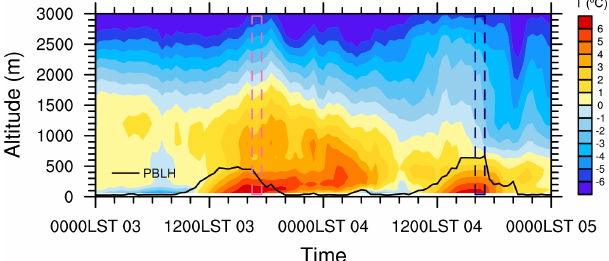
Figure 4. Temporal evolution of the EXP_Ctrl simulated temper- ature profile over Baoding. The pink and blue dashed boxes corre- spond to the aircraft observation periods on 3 and 4 January, respec- tively. The black line indicates the planetary boundary layer height